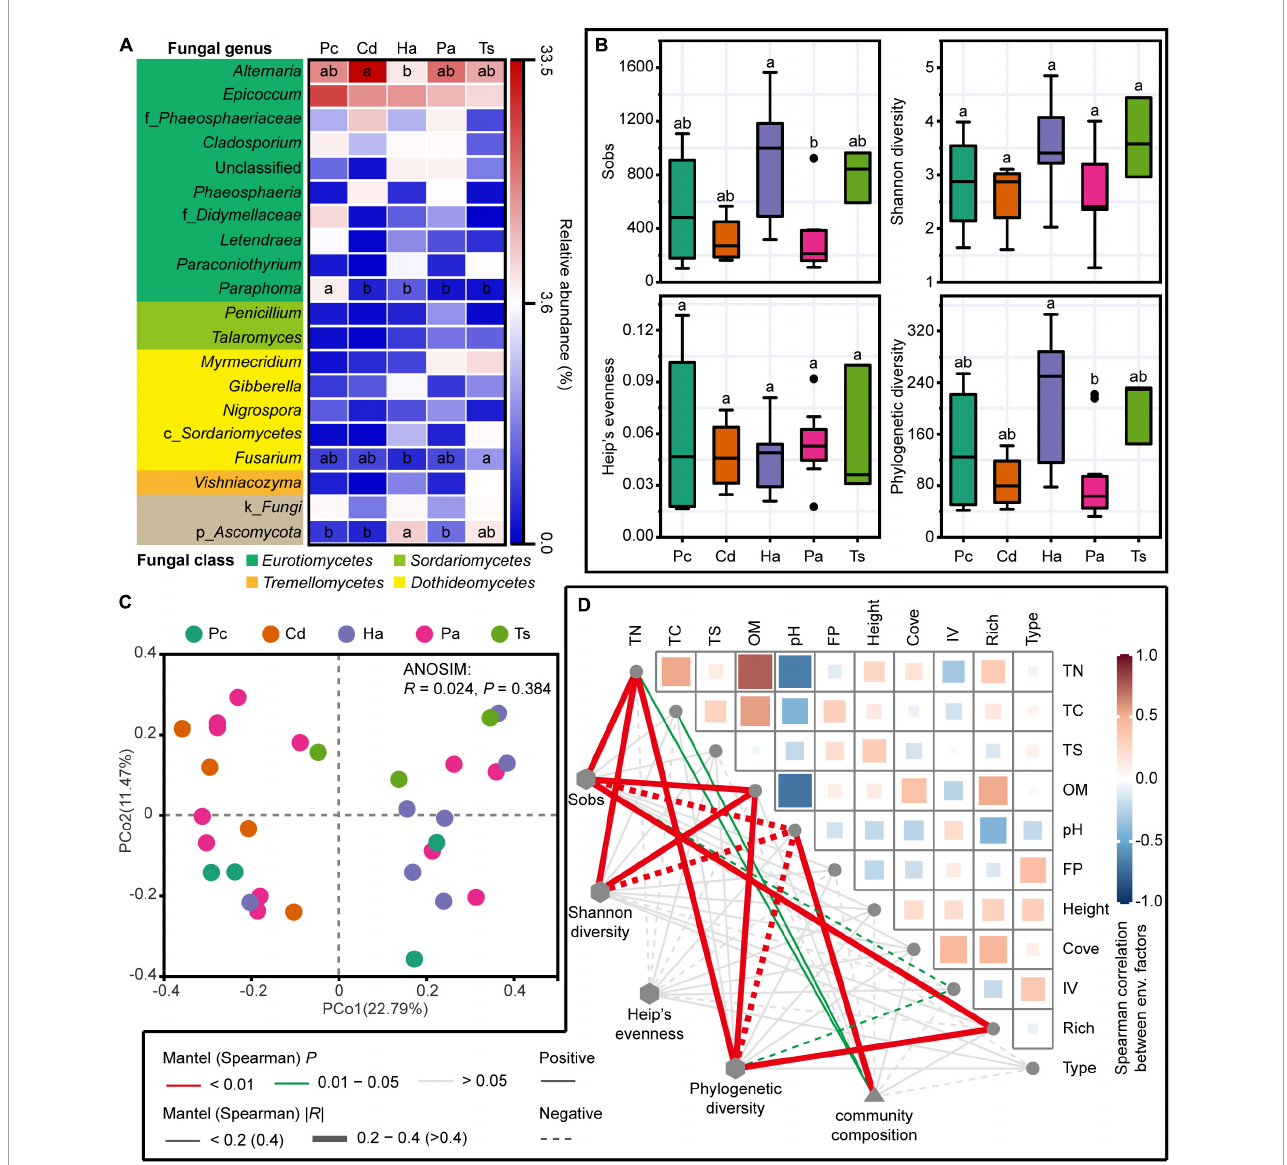
FIGURE2 Fungal communities in rhizosphere soils. (A) The dominant fungal genera (sequences accounting for > 1% of the total sequences of all samples) and (B) alpha diversity indices of fungal communities in rhizosphere soils across different plant species. Different lowercase letters indicate significant differences among different plant species at 0.05 level of significance based on one-way analysis of variance (ANOVA) with least significant difference (LSD) multiple comparisons. Pc, P. communis ; Cd, C. dactylon ; Pa, P. arundinacea ; Ha, H. altissima ; Ts, T. sacchariflora . (C) Principal co-ordinate analysis (PCoA) of rhizosphere fungal communities at operational taxonomic unit (OTU) level based on Bray–Curtis distance. Analysis of similarity (ANOSIM) of rhizosphere fungal communities among different plant species based on Bray–Curtis distance with 999 permutations. (D) Correlations of fungal community diversity and composition with soil environmental factors and aboveground plant traits. Spearman’s correlations were performed between alpha diversity indices, soil environmental factors and plant traits. Mantel tests were executed between fungal community composition and soil environmental factors and plant traits. FP, flooding probability; Cove, coverage of plant species; IV, importance value; Rich, richness of plant species; Type, type of plant